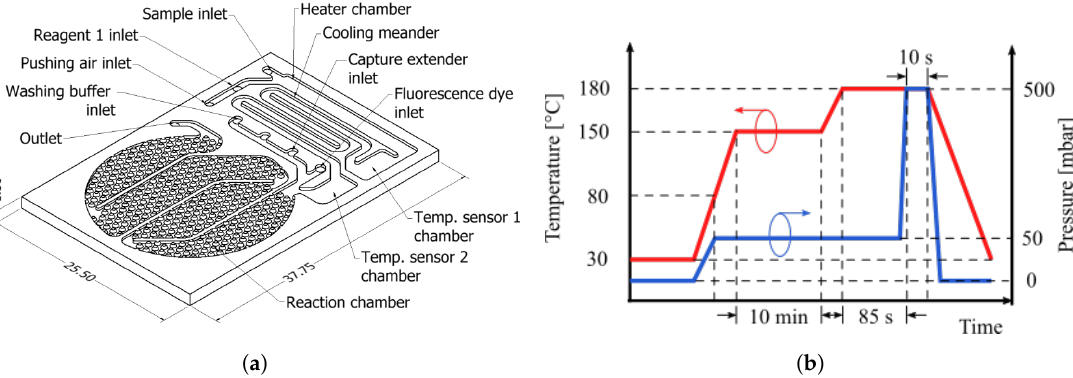
Figure 1. ( a ) Description of the manufactured biosensor. Dimension in milimeters. ( b ) Diagram of the applied hot embossing process parameters vs.